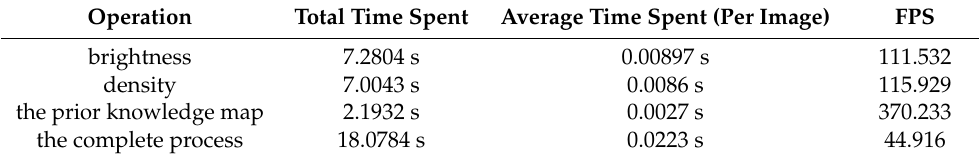
Table 5. Time consumption of combining the prior knowledge with